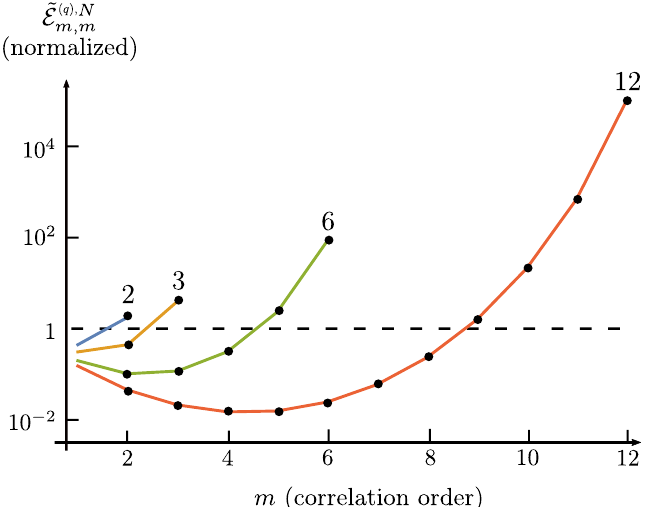
Figure 5: The correlator from Eq. (47) calculated with the fixed- N part [ see Eq. (43) ] of the full state [ Eq. (39) ] for N = 2,3,6 and 12, as a function of m ∈ [ 1,... N ] and normalized to the local realistic bound from Eq. (48). Contrary to the correlator ˜ E calculated with a full state, which does not break the Bell inequality with m = 2,3,5 and 6, here the bound is surpassed (for instance N = 6 and m =